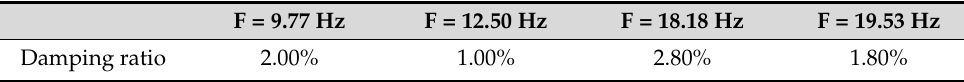
Table 6. Damping ratios identified in correspondence of the experimental modes.